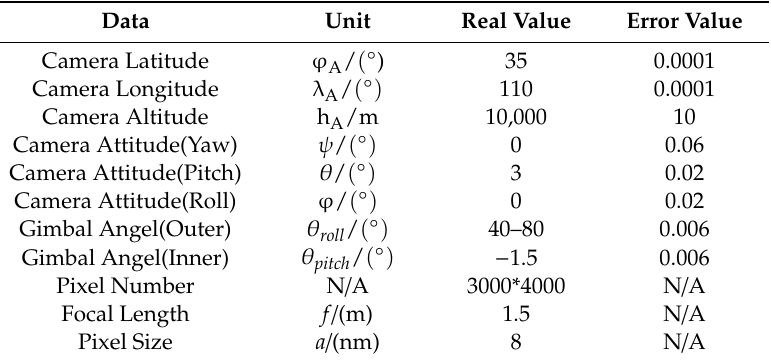
Table 1. Simulation experiment parameters.